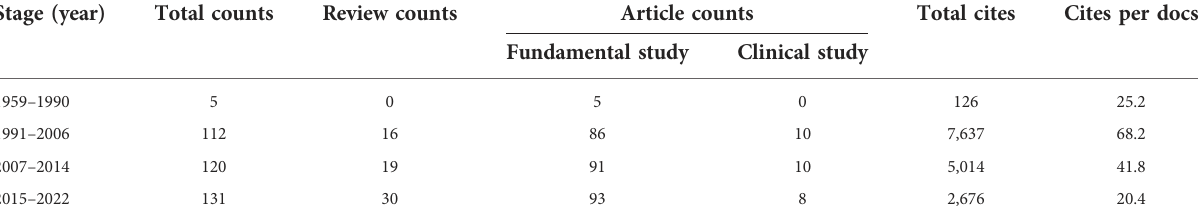
TABLE 1 The four-stage pattern of the effect of skin innervation on wound healing. Stage